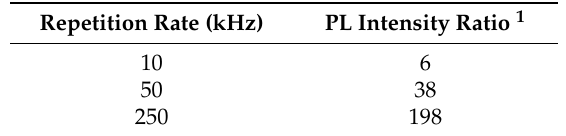
Table 1. PL intensity ratios before and after the laser irradiation.